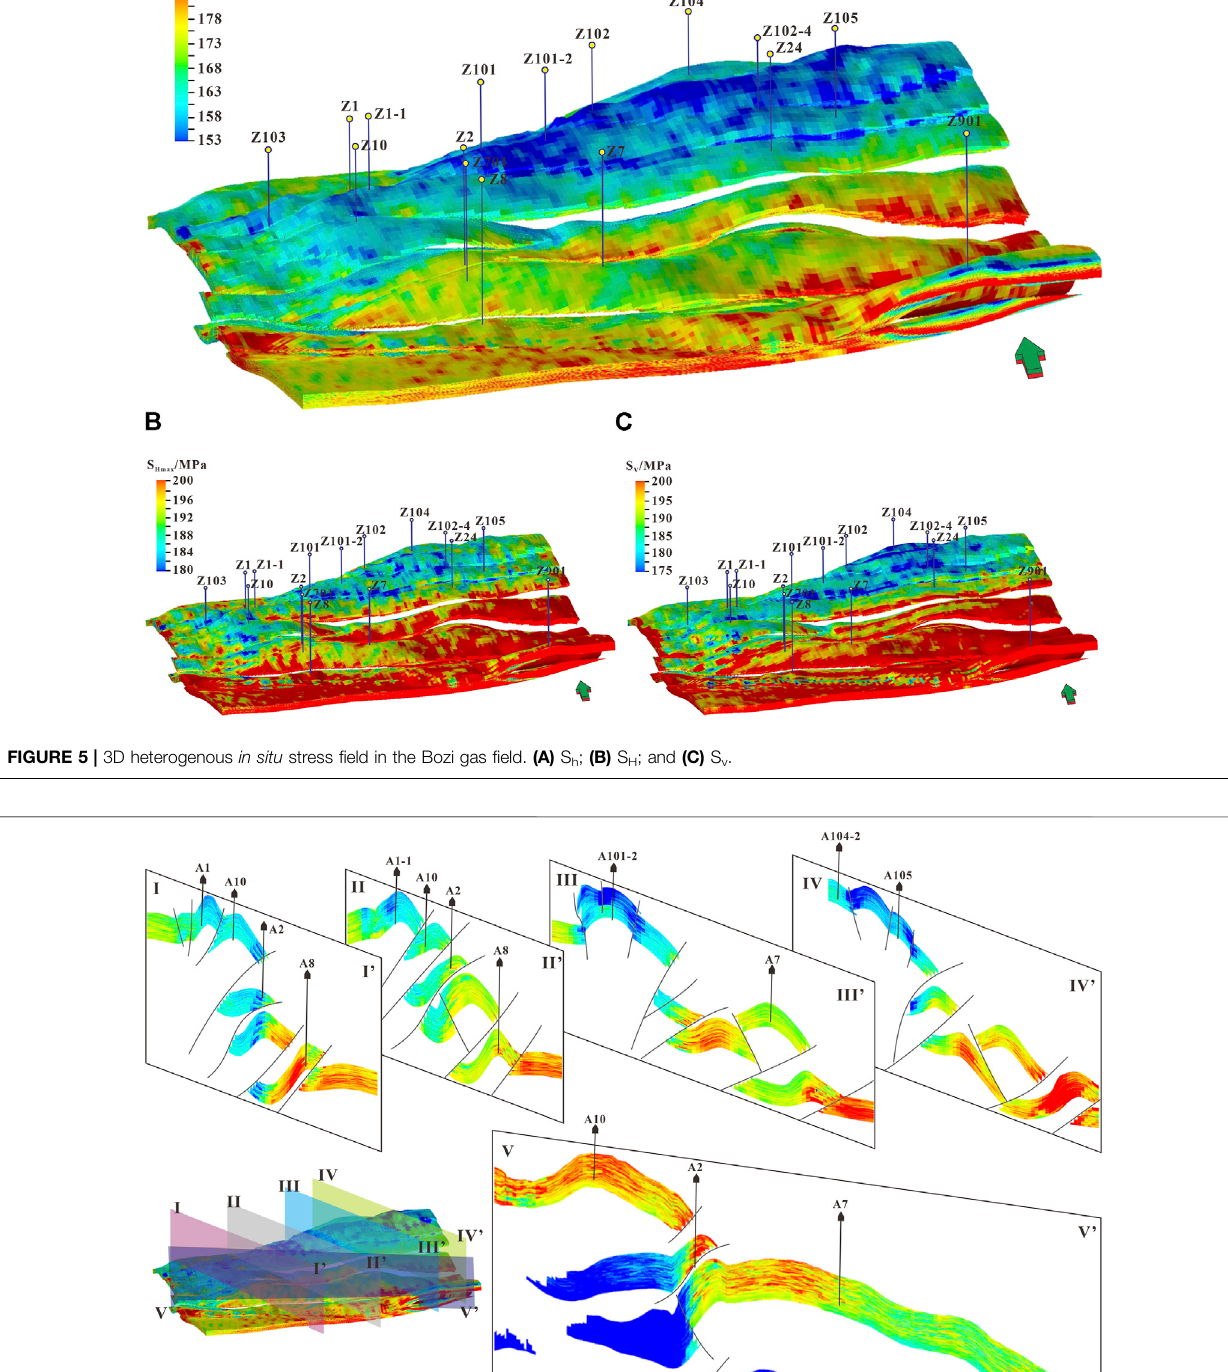
Frontiers in Earth Science |